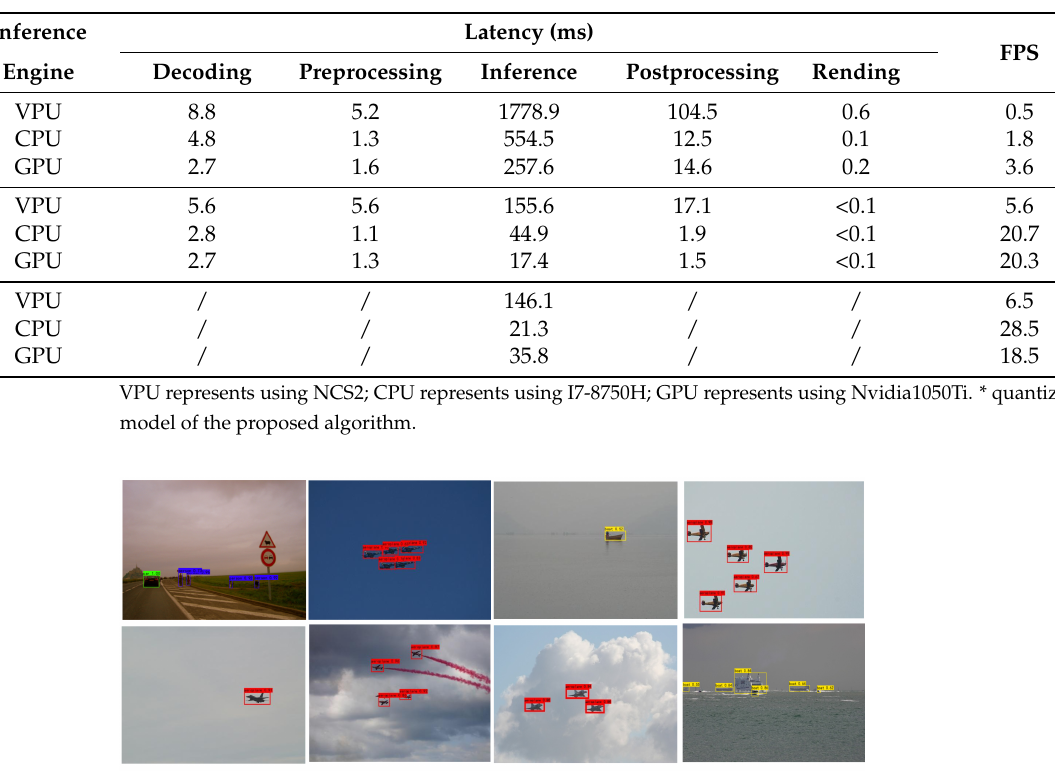
Figure 16. Visualization of inference results in ARM based on